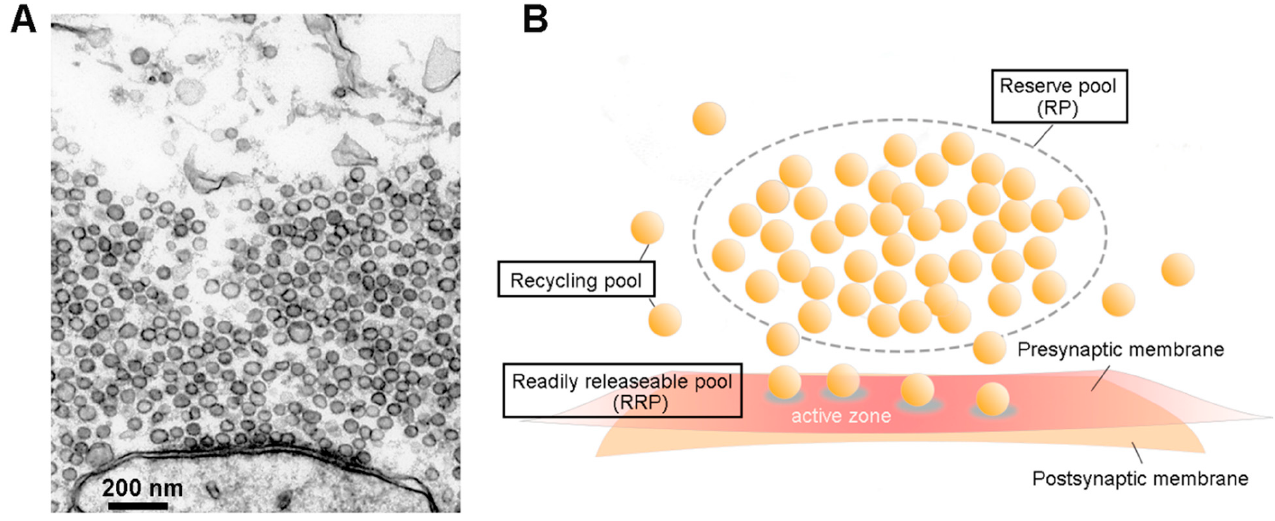
Figure 1. Synaptic vesicles (SVs) and their pools. ( A ). Electron micrograph of an active zone (AZ) from a squid giant synapse. SVs are the dark, membrane-bound circles that are both attached to the presynaptic plasma membrane and clustered nearby. ( B ). Classification of SV pools. A reserve pool (RP) occupies the distal volume of the presynaptic terminal, while a readily releasable pool (RRP) consists of vesicles docked at the AZ. The other freely moving SVs are assigned to a recycling pool.